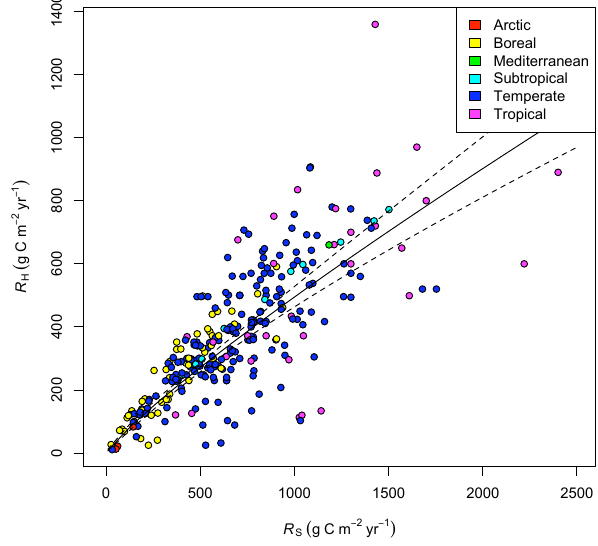
Fig. 6. Relationship between soil respiration ( R S ) and het- erotrophic soil respiration ( R H ) in the database, by biome, follow- ing Bond-Lamberty et al. (2004). Fitted model shown (solid line) is ln( R H ) =0.22+0.87ln( R S ) , R 2 = 0 . 64, P < 0 . 001; dashed lines show 95% confidence interval. Two studies (Grier and Logan, 1977; Thierron and Laudelout, 1996) in the database were excluded from this figure based on a Cook’s influential outlier test (R Development Core Team,